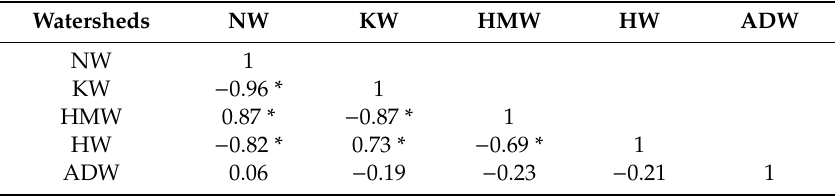
Table 4. The correlation matrix of time series of vegetation coverages between five watersheds in the study area between 2001 and 2018.